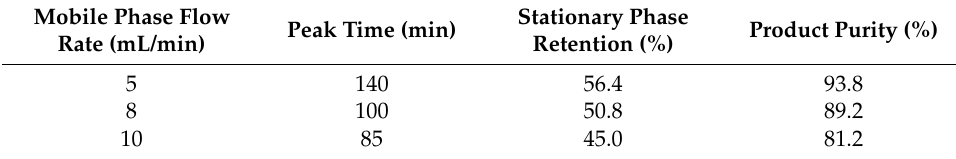
Table 3. Effect of mobile phase flow rate on the separation